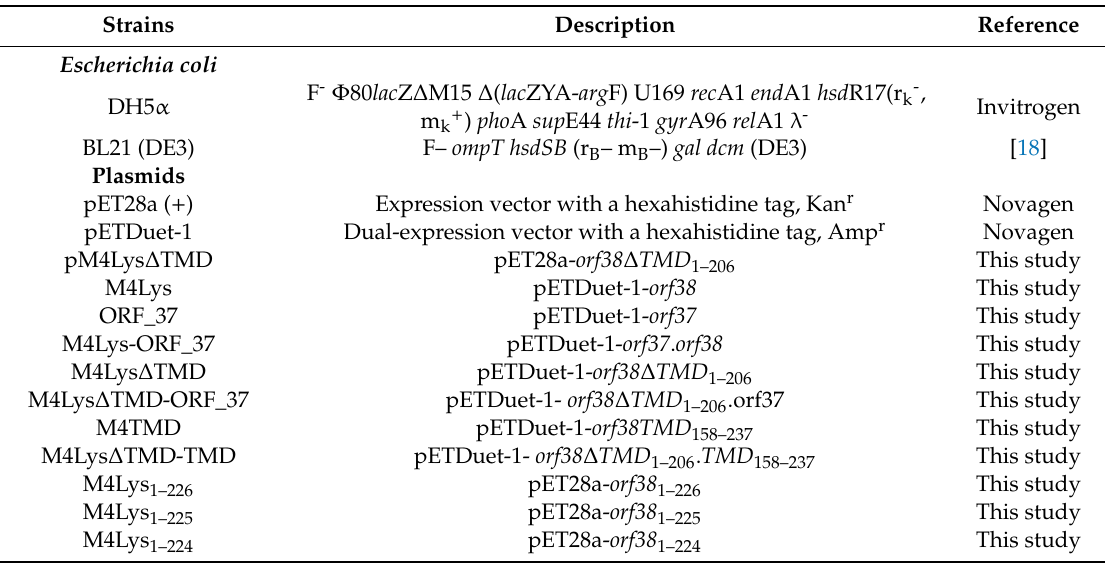
Table 1. Bacterial strains and plasmids in this